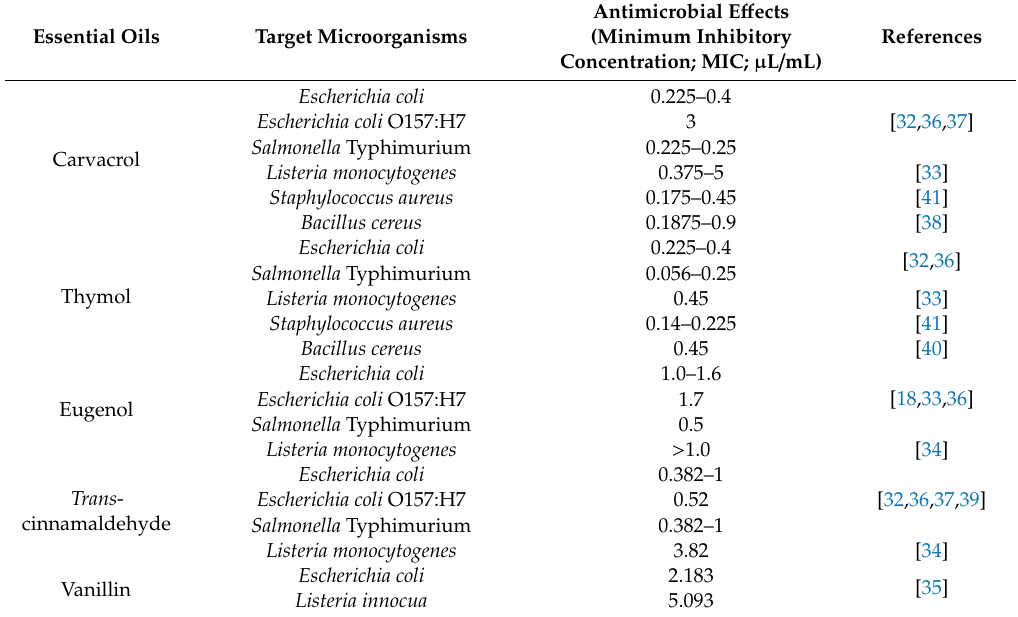
Table 1. Minimum inhibitory concentration of representative essential